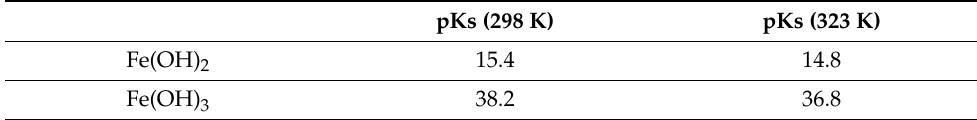
Table 2. Temperature dependence of the water solubility of Fe 2+ and Fe 3+ ions.